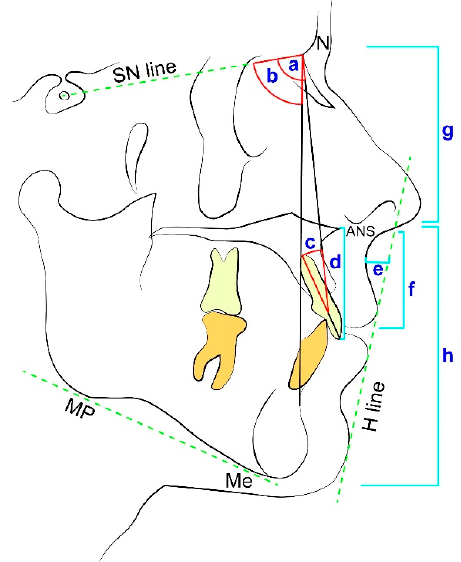
Figure 2. Cephalometric measurements used in the study: Sella–Nasion–A point angle (SNA) (a), Sella–Nasion–B point angle (SNB) (b), Upper incisors - Nasion- A point angle (U1 to NA) (c), incisor-maxilla height (d), sulcus depth (e) and upper lip height (f), vertical anterior upper proportions